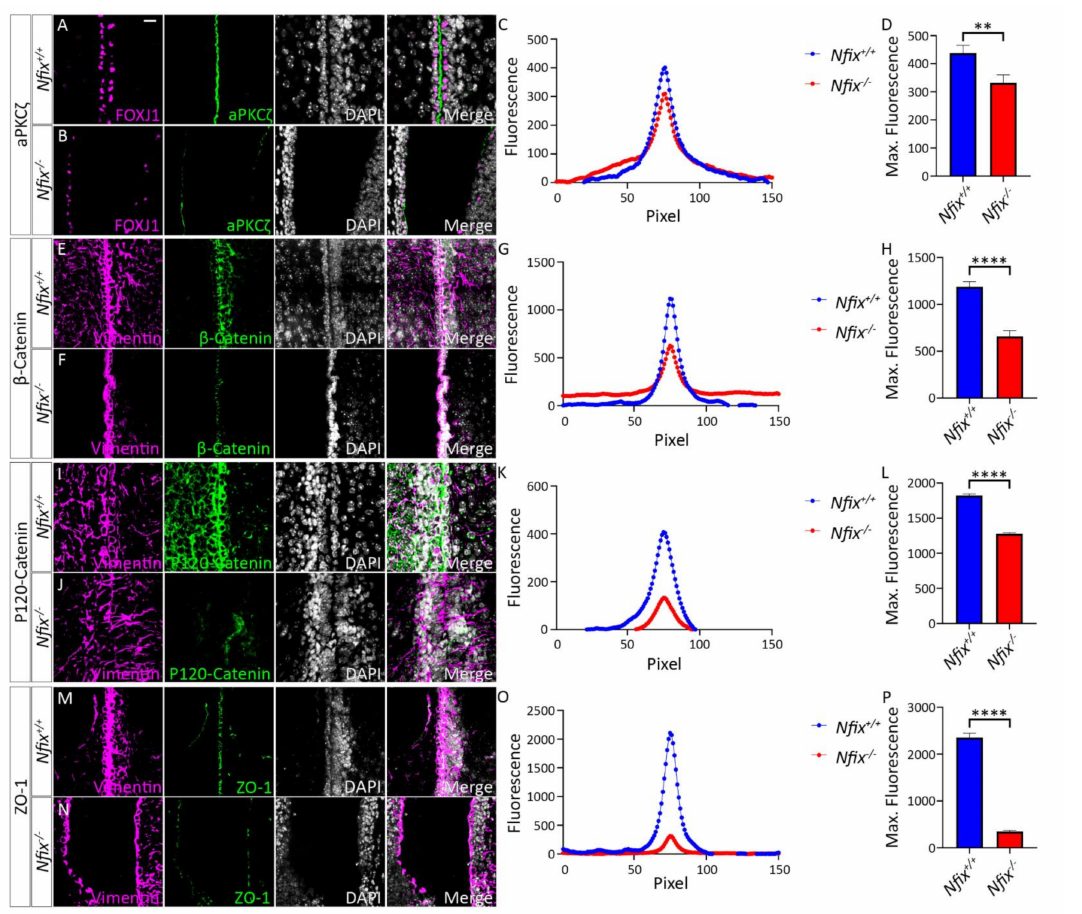
Figure 1. P5 Nfix − / − mice demonstrate abnormal localisation of key adhesion proteins to the cell junction. ( A , B , M , N ) Images of brain lateral ventricles from P5 Nfix +/+ ( A ) and Nfix − / − ( B ) mice marked with antibodies against ependymal marker FOXJ1 ( A , B ) or Vimentin ( M , N ) (purple), tight junction protein aPKC ζ ( A , B ) or ZO-1 ( M , N ) (green) and nuclear marker DAPI (grey) displayed sepa- rately and merged for each genotype. ( C , O ) Average fluorescence intensity of aPKC ζ ( C ) and ZO-1 ( O ) across the cell junctions of Nfix − / − (red) and Nfix +/+ (blue) ependymal cells. The peak fluorescence intensities of aPKC ζ and ZO-1 are lowered in Nfix − / − mice compared to controls. ( D , P ) Maximum fluorescent intensities of aPKC ζ ( D ) and ZO-1 ( P ) across the cell junctions of Nfix − / − (red) and Nfix +/+ (blue) ependymal cells. Maximum fluorescent intensity of aPKC ζ is significantly reduced in Nfix − / − mice compared to controls. ( E , F , I , J ) Images of brain lateral ventricles from P5 Nfix +/+ ( E , I ) and Nfix − / − ( F , J ) mice marked with antibodies against ependymal marker vimentin (purple), adherens junction protein β -Catenin ( E , F ) or P120-Catenin ( I , J ) (green) and nuclear marker DAPI (grey) displayed separately and merged for each genotype. ( G , K ) Average fluorescent intensities of β -Catenin ( G ) and P120-Catenin ( K ) across the cell junctions of Nfix − / − (red) and Nfix +/+ (blue) ependymal cells. The peak fluorescence of β -Catenin and P120-Catenin are lowered in Nfix − / − mice compared to controls. ( H , L ) Maximum fluorescent intensities of β -Catenin ( F ) and P120-Catenin ( L ) across the cell junctions of Nfix − / − (red) and Nfix +/+ (blue) ependymal cells. Maximum fluorescent intensity of β -Catenin is significantly reduced in Nfix − / − mice compared to controls. ** p < 0.01, **** p < 0.0001 two-tailed t -test. Graphs depict mean ± s.e.m. from three samples per genotype with an n of 150 junctions. Scale bar ( A ) represents 20 µ